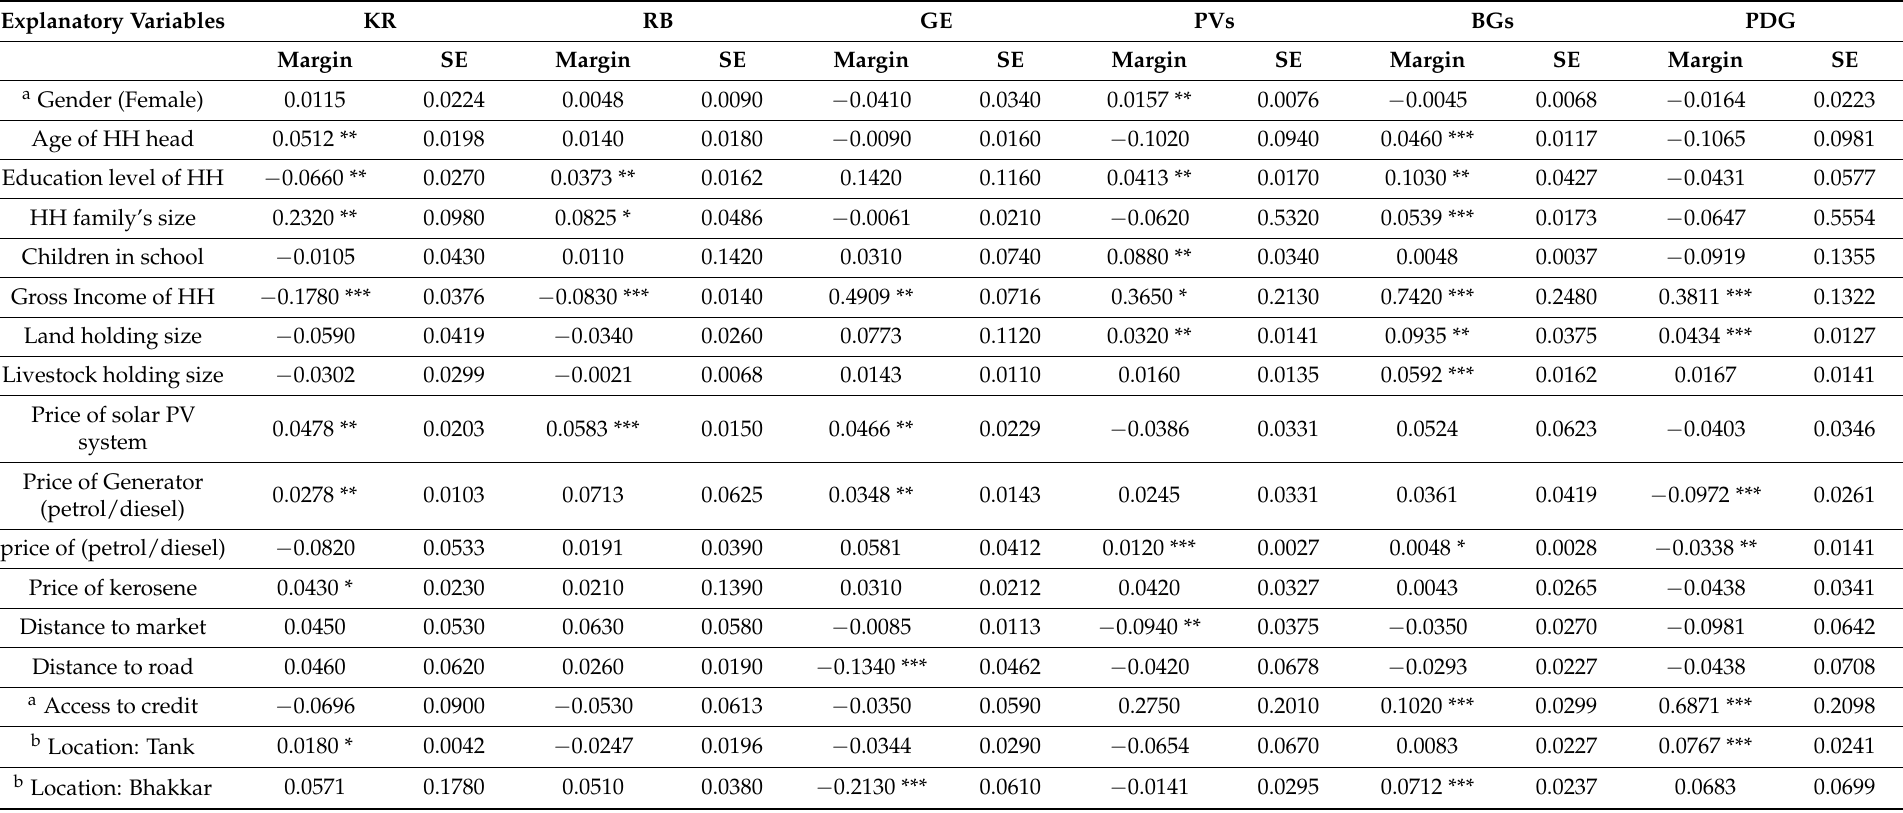
Table 8. Marginal effects of explanatory variables effecting the households’ lighting